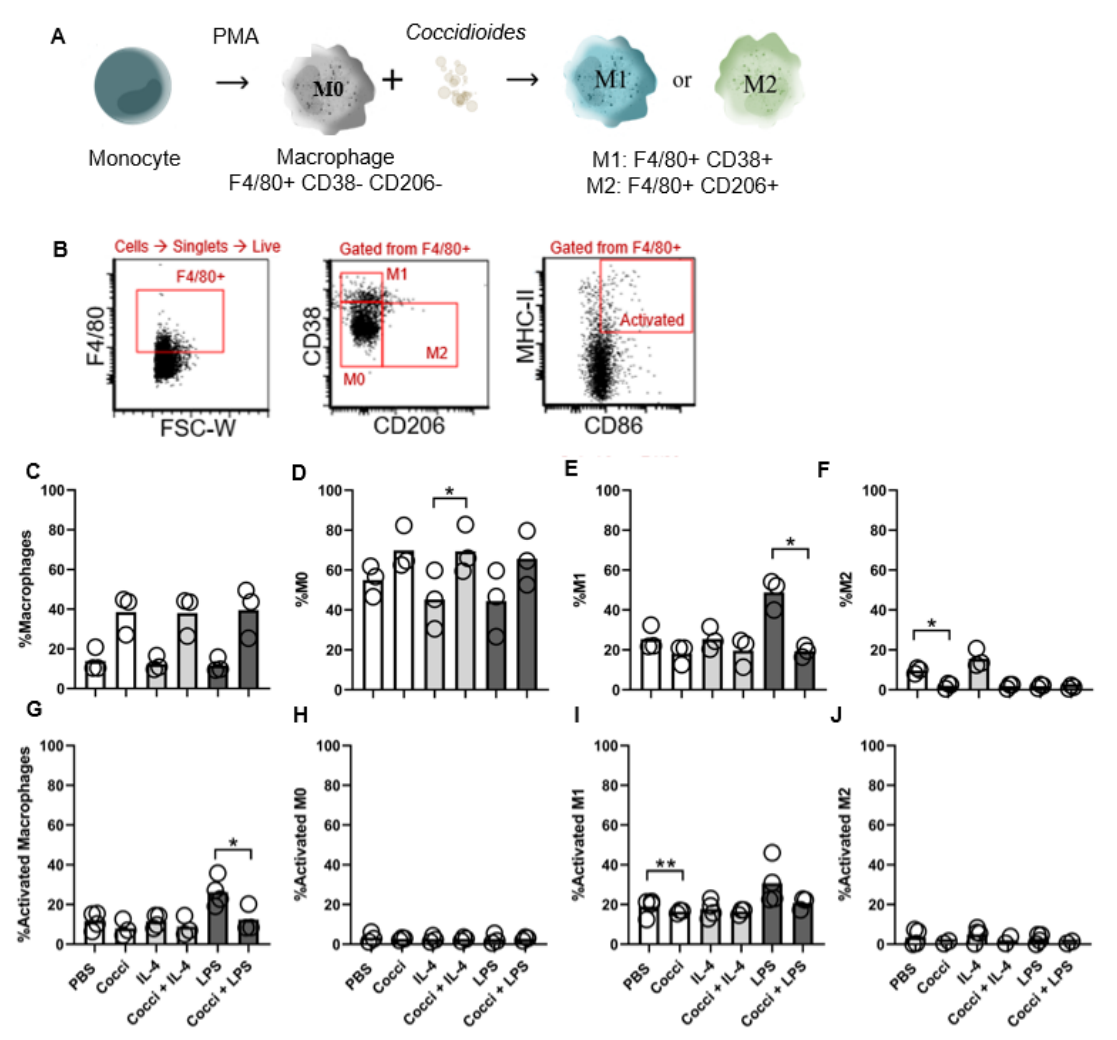
Figure 2. Monocytes activate into macrophage in response to Coccidioides but do not polarize into M1/M2 subtypes and largely lack activation/maturation markers. ( A ) Schematic illustrates monocytes differentiation into M0 and polarized M1/M2 potential outcomes with Coccidioides . PMA (phorbol 12-myristate 13-acetate), an activator of protein kinase C (PKC), was used as a positive stimulant for M0. LPS (100 ng/mL) acted as M1 positive control and IL-4 (20 ng/mL) as M2 positive control. Cocci = Coccidioides added at 1:1 ratio with cells. ( B ) Representative flow plots show the gating strategy for analysis; sample shown was stimulated with Coccidioides . See Supplemental Figure S4 for complete gating strategy. ( C , G ) macrophages are defined as all F4/80+ cells, ( D , H ) M0 defined as CD11b-F4/80+, ( E , I ) M1 as CD38+ F4/80+, and ( F , J ) M2 as CD206+ F4/80+. ( G – J ) Activated cells are defined as CD86+MHC-II+ and are gated off their respective population. n = 3–4, data representative of 3 experiments. The bar within each data group indicates the mean, each individual circle represents one biological replicate averaged from all technical replicates within each experiment. Statistics show comparisons between Coccidioides and non- Coccidioides conditions. Data was analyzed using unpaired Student’s t -test. * p < 0.05, ** p <